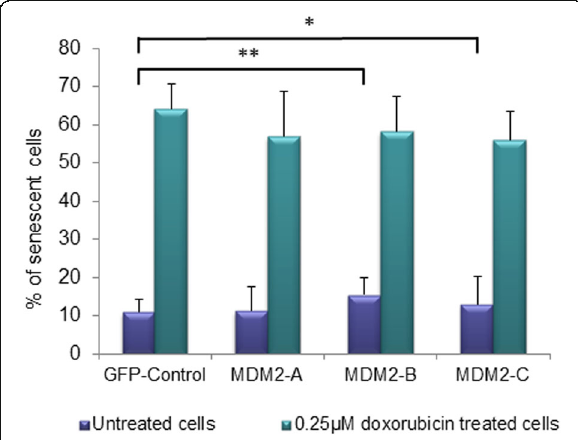
Fig. 7 Induction of senescence. Graphs show the percentage of senescent cells after transfection with pCMV (TOPO-Control) and the splice variants, untreated ( purple bars ) or treated with 0.25 μ M doxorubicin ( green bars ). Cells were analyzed by β